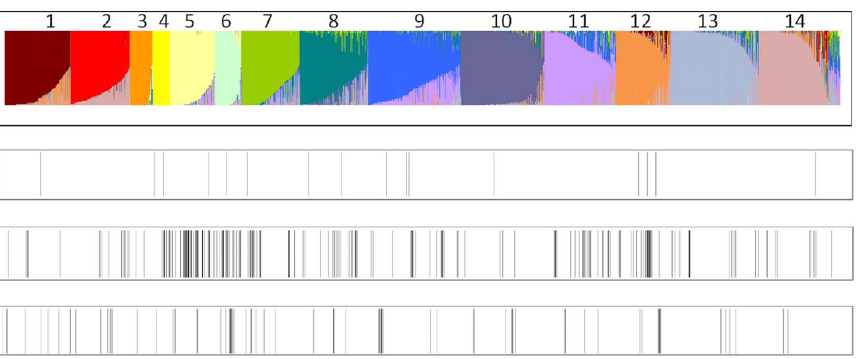
Figure 5. Visualization of genetic relationship of four identified eIF4E variants on the background of 14 BAPS identified clusters of 3,029 JIC accessions genotyped by 45 retrotransposon-insertion loci [ 13,63 ] . Notably, clusters 3 and 4 contain 145 acc. of wild P. fulvum, P. s. subsp. elatius and P. abyssinicum ; cluster 7 contains 95 acc. from Afghanistan; cluster 8 has 225 acc. from Ethiopia; and cluster 9 contains 247 acc. from India and Ethiopia, while remaining clusters are more diverse (A). 18 accessions with the eIF4E A (B), 241 accessions with the eIF4E B (C), 81 accessions with the eIF4E C variant (D).